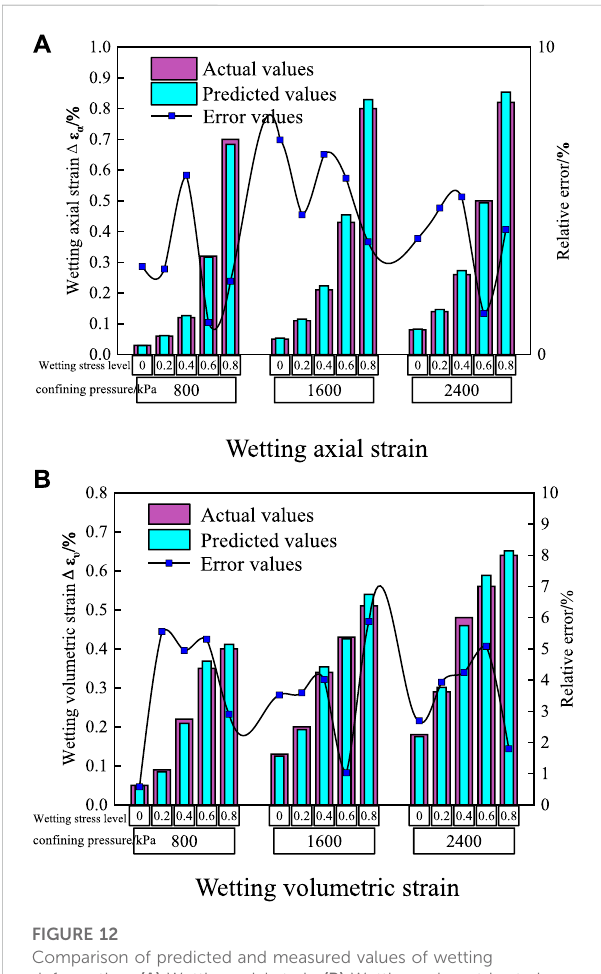
FIGURE 12 Comparison of predicted and measured values of wetting deformation. (A) Wetting axial strain (B) Wetting volumetric